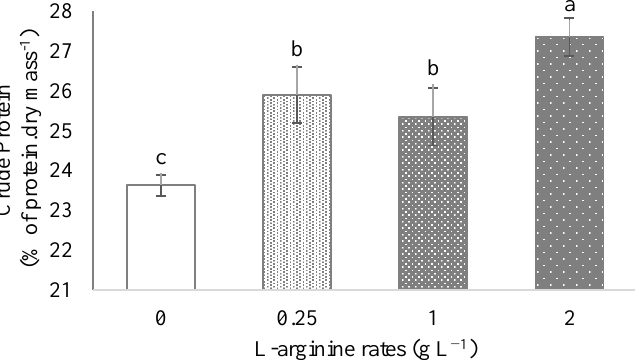
Figure 2. Crude protein in ora-pro-nobis leaves in function of different rates of exogenous L-arginine application. Data followed by the same letter did not differ from each other by Tukey range test at p ≤ 0.05.